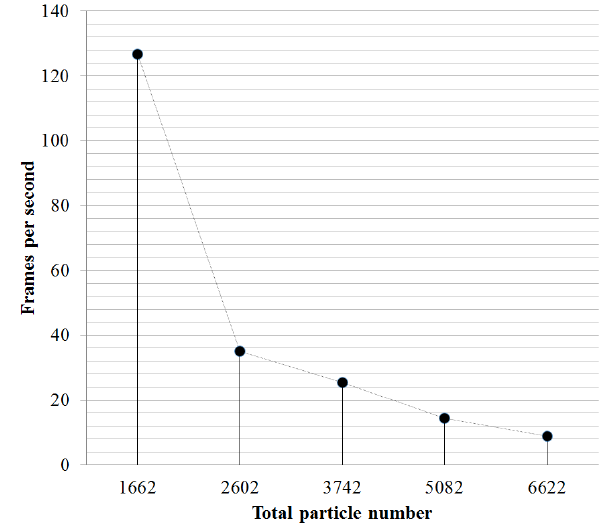
Fig. 16: Frame rate as the total particle number increases on